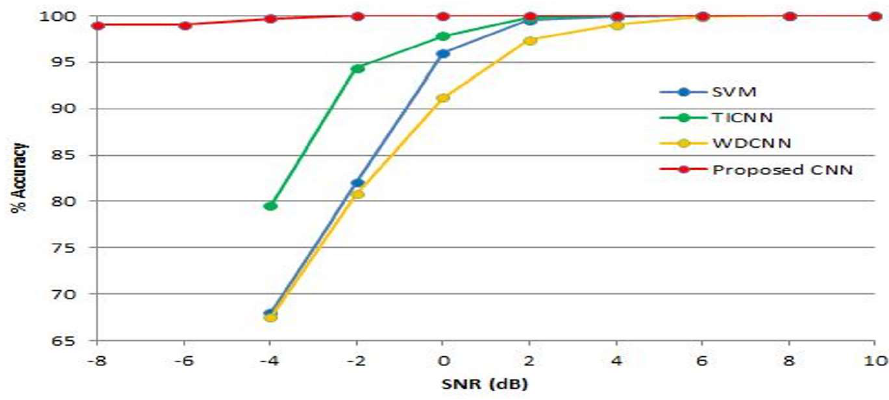
Figure 10. Performance in a noisy environment.